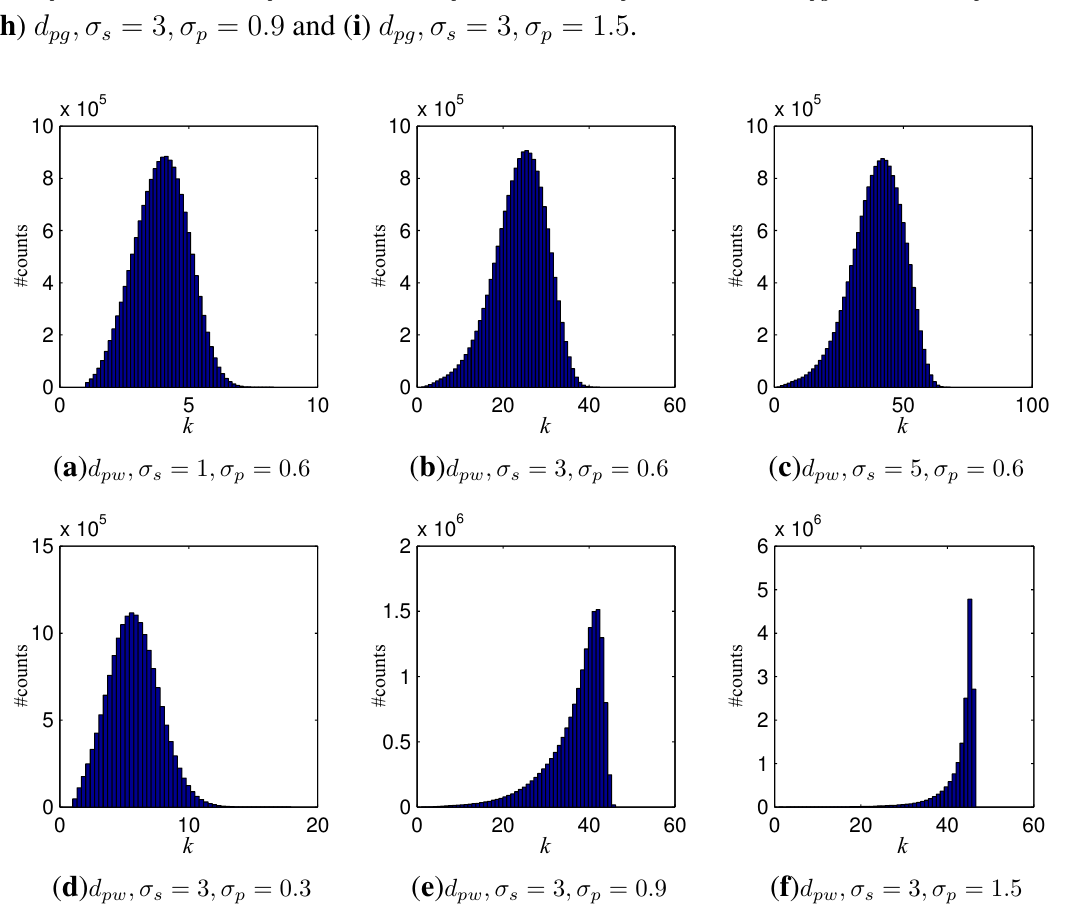
and σ with 5 s p = 1 , σ = 0 . 6 , , σ pw s p = 3 , σ = 0 . 3 , σ pw s p